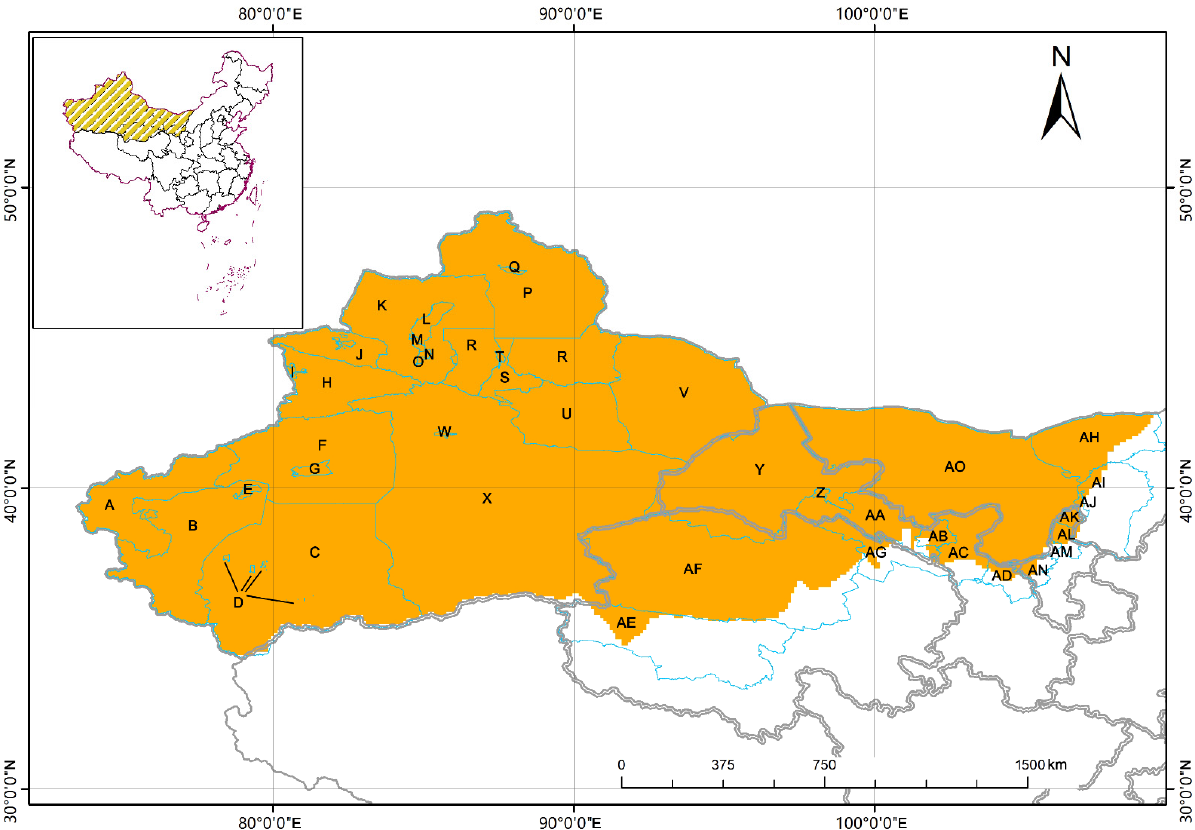
Figure 1. Map of arid desert areas in Northwest China. A: Kizilsu Kirgiz; B: Kashgar; C: Hotan; D: